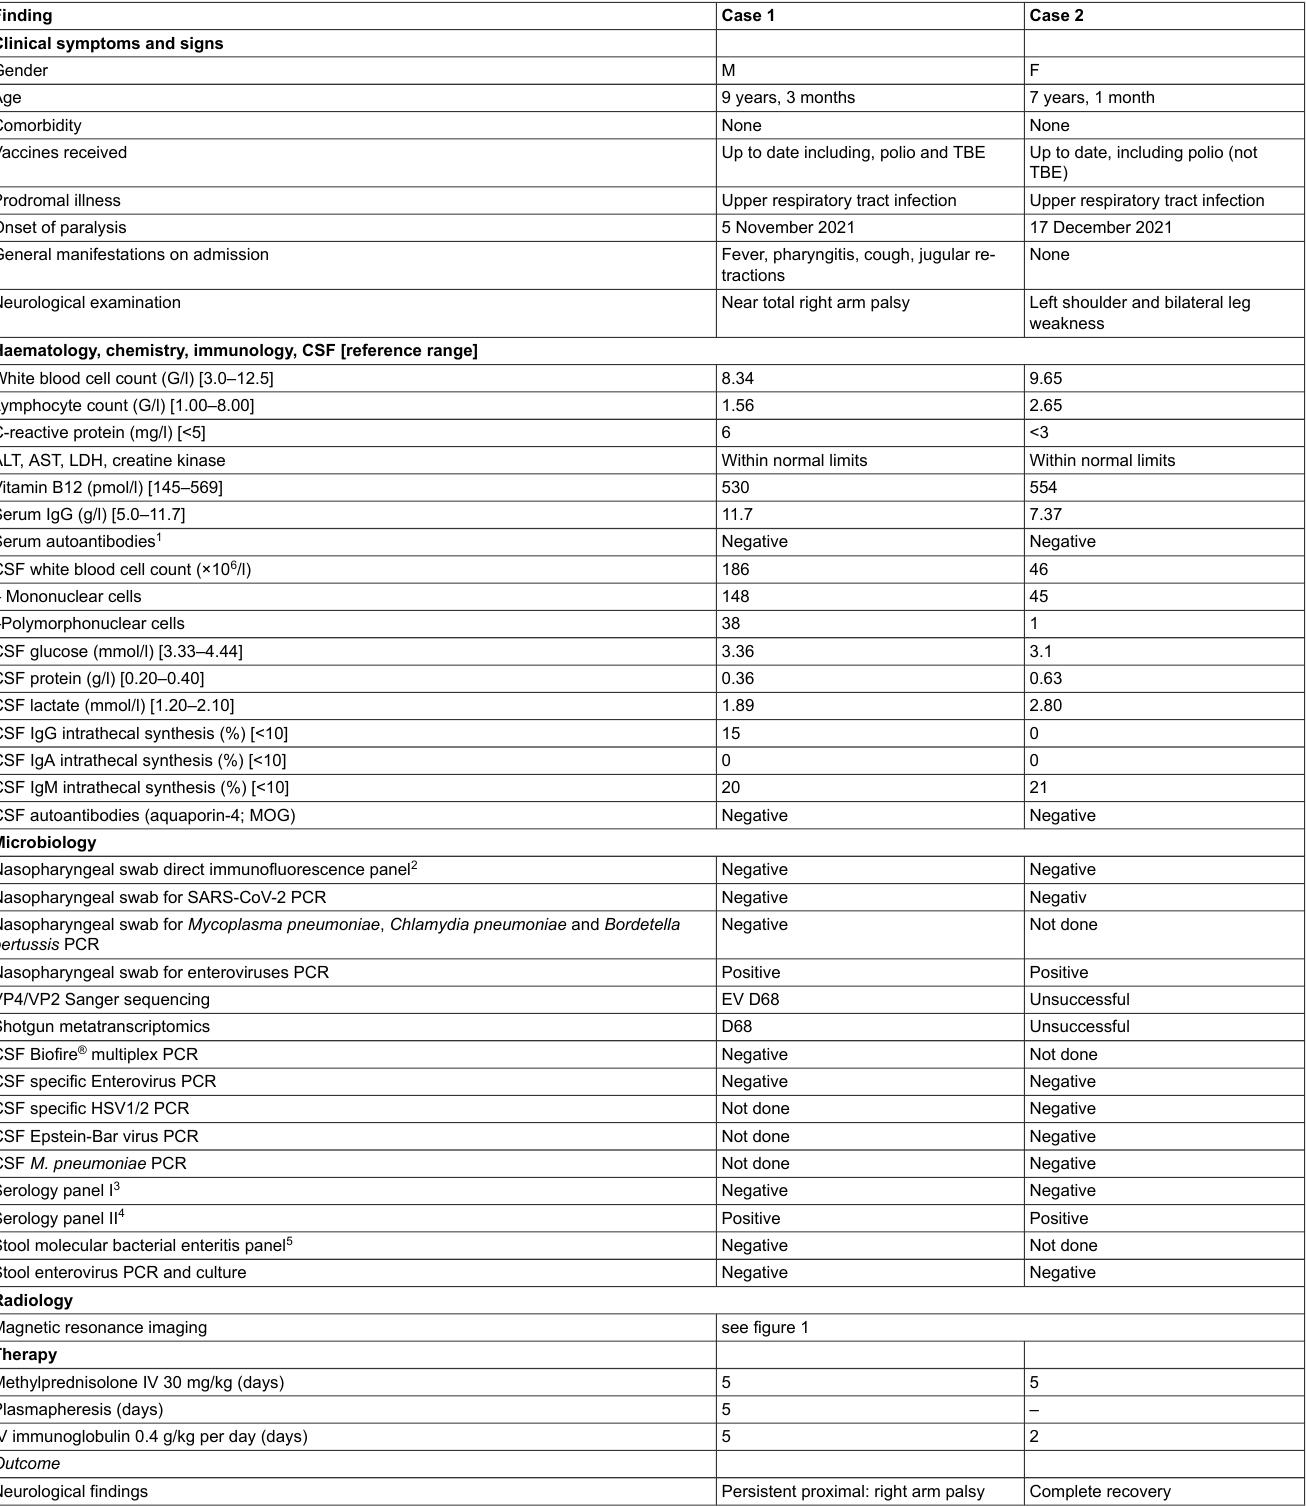
Table 1: Clinical, laboratory, radiology findings and management of two cases with acute flaccid myelitis.